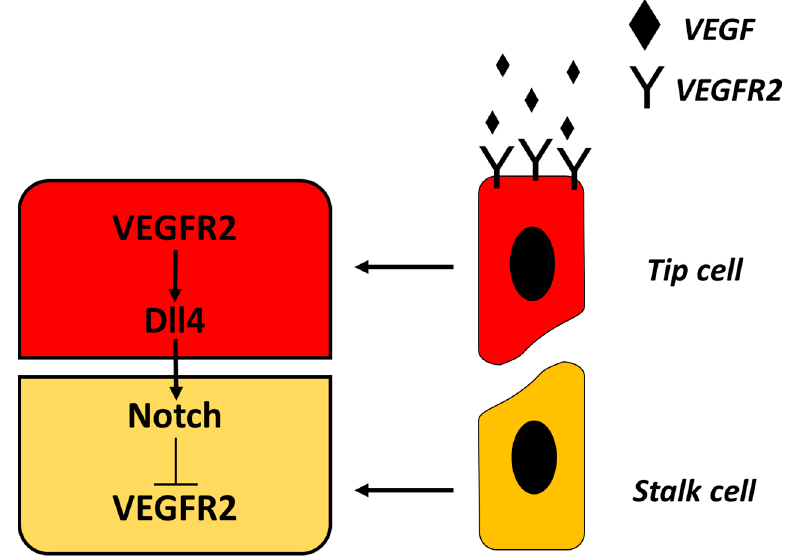
Figure 1. Current model of VEGF-Notch signaling pathway.